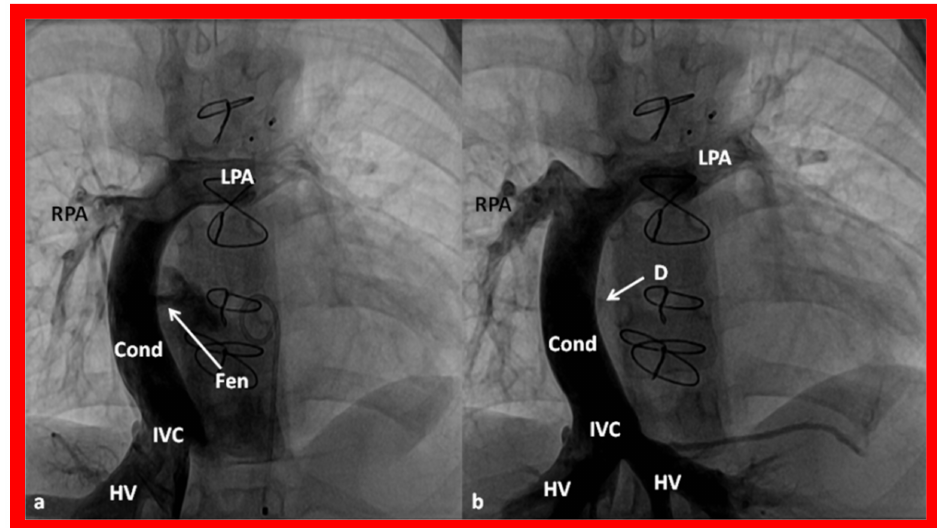
Figure 18. Cine-angiographic images in antero-posterior projection, illustrating Stage IIIA Fontan operation transmitting blood flow from the inferior vena cava (IVC) into the pulmonary arteries